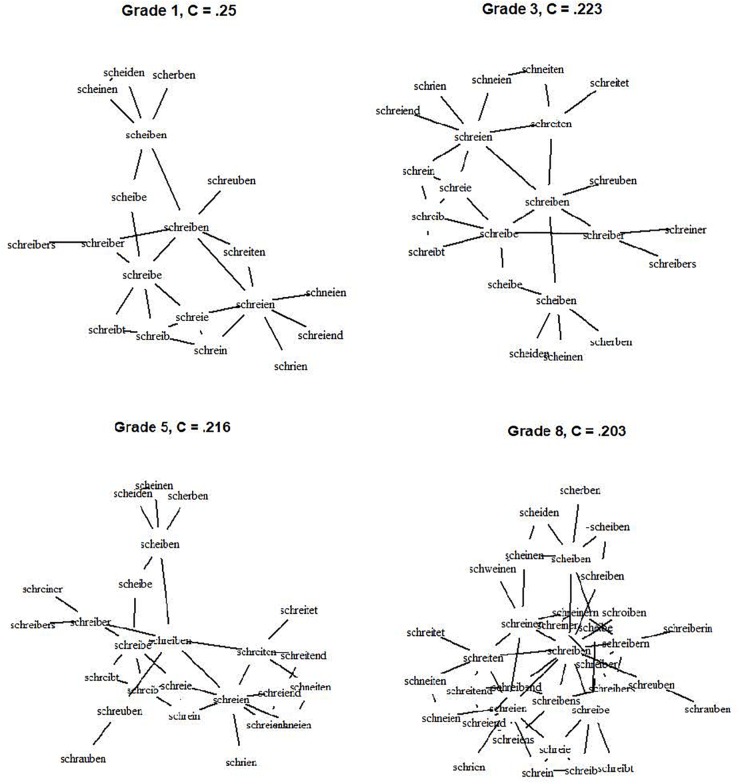
The network and according clustering coefficient for the word “schreiben” – “to write.” Note that for reasons of comprehensibility only neighbors of a maximal Levenshtein distance of 2 are depicted.